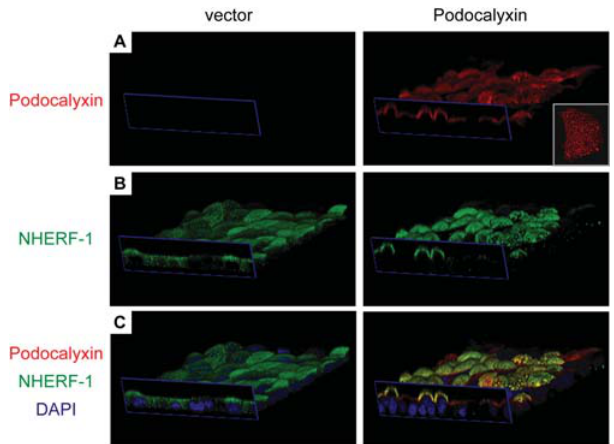
Figure 3. Podocalyxin induces apical expansion and recruits NHERF-1 to the apical membrane. 3D images of empty vector and Podocalyxin- transfected MCF-7 cells showing ectopic Podocalyxin (red), endogenous NHERF-1 (green), and DAPI (blue) labeling. Dimensions of blue rectangles: 118 6 26 m m. (A) Podocalyxin-transfected cells labeled with an anti-Podocalyxin antibody. (B) The same cells labeled with an anti- NHERF-1 antibody. (C) Merged images showing Podocalyxin, NHERF-1, and DAPI labeling. Inset in (A): projection of apical surface of a single Podocalyxin-transfected MCF-7 cell, labeled with an anti-Podocalyxin